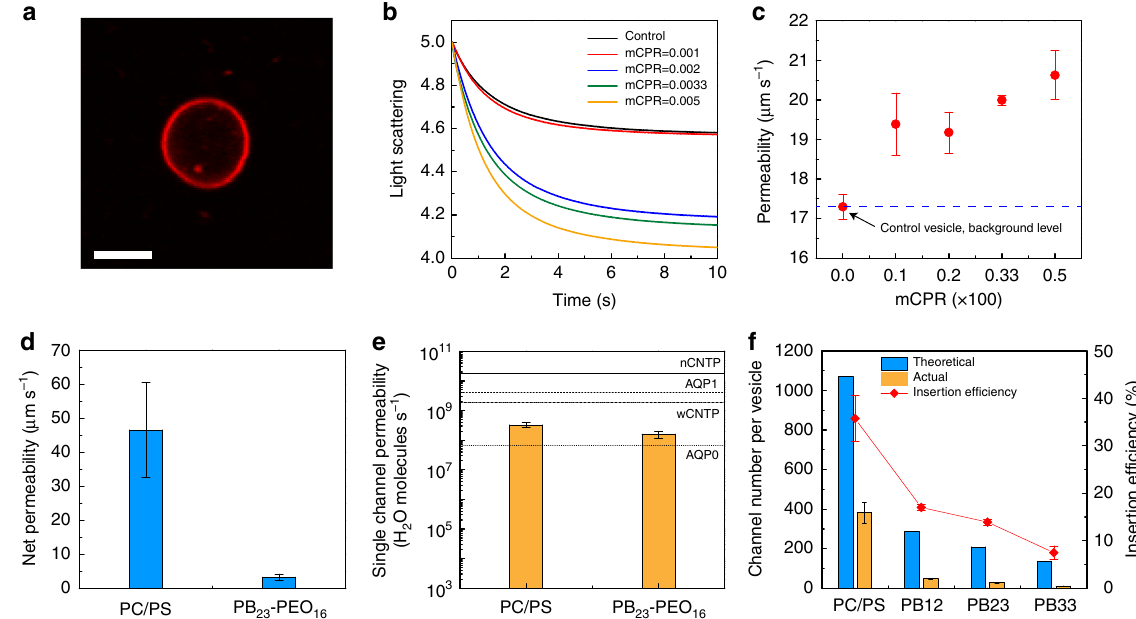
Fig. 2 Peptide-appended pillar[5]arene (PAP) channels maintain an aquaporin-like single channel permeability in block copolymer bilayers. a Confocal fl uorescence microscope image of a giant unilamellar vesicle showing the incorporation of fl uorescently labeled PAP channels into PB23 polymersomes. Block copolymers were not labeled. Scale bar, 5 μ m. b Representative light scattering traces of PB23 polymersomes with different molar channel-to- polymer ratios (mCPRs) after a rapid exposure to a hypotonic solution in a stopped- fl ow instrument. The hypotonic solution lacked the 100 mM PEG600 used to form the vesicles. c The water permeability of PAP channel-containing PB23 polymersomes formed with different mCPRs measured under hypotonic conditions. The dash line showed the background permeability level of a control PB23 vesicle. d Net water permeability of PAP channels in liposomes (4:1 (mol/mol) phosphatidylcholine/phosphatidylserine (PC/PS), molar channel-to-lipid ratio (mCLR) is 0.005), and in PB23 polymersomes (mCPR = 0.005) after subtraction of the background permeability of control vesicles shown in c . e Single channel water permeability of PAP channels in PC/PS liposomes and PB23 polymersomes. The permeabilities of AQP1, AQP0 and CNTP are from Zeidel et al. 30 , Saobe et al. 31 , and Tunuguntla et al. 12 , respectively. f The insertion ef fi ciency of PAP channels in PC/PS liposomes and PB-PEO polymersomes was determined using fl uorescence correlation spectroscopy (FCS) measurements. The calculation of insertion ef fi ciency is described in detail in Supplementary Methods. Data shown are the average